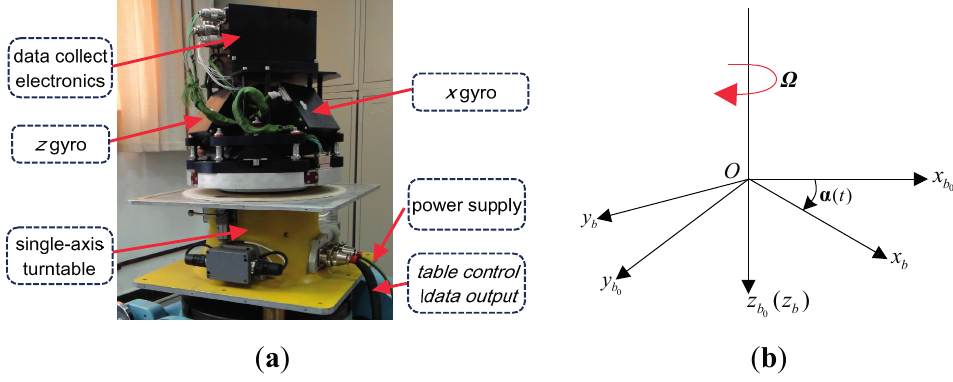
Figure 1. The experimental set-up and definition of coordinate frames in the ARIMU. ( a ) The experimental set-up; ( b ) Definition of coordinate frames in the